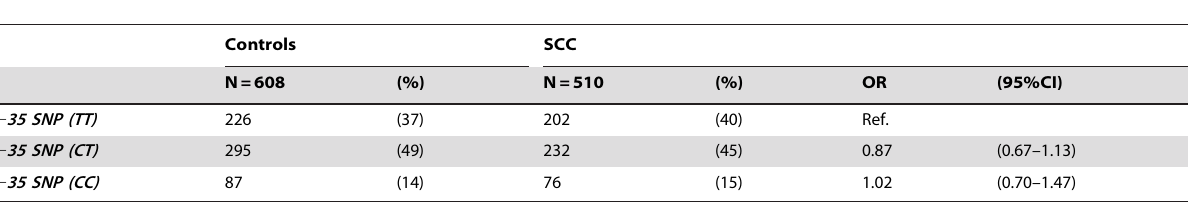
Table 4. Association of 2 35 kb SNP with case status.